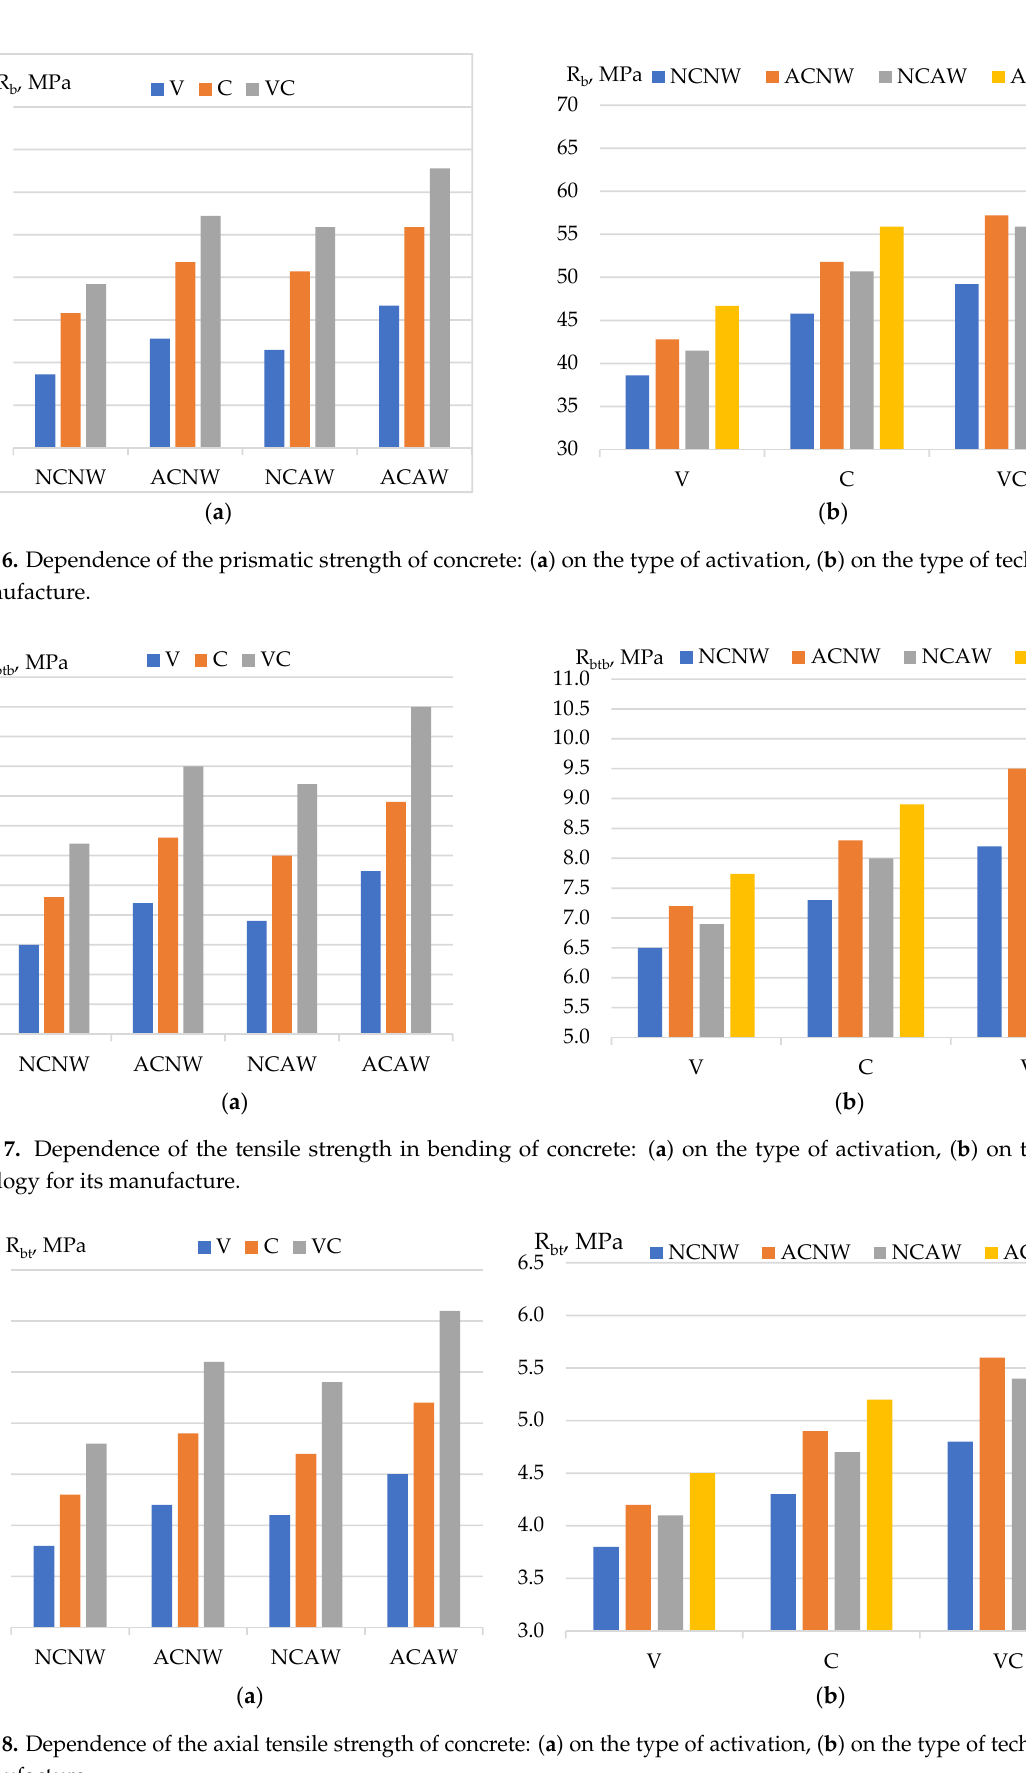
Figure 8. Dependence of the axial tensile strength of concrete: ( a ) on the type of activation, ( b ) on the type of technology for its manufacture.